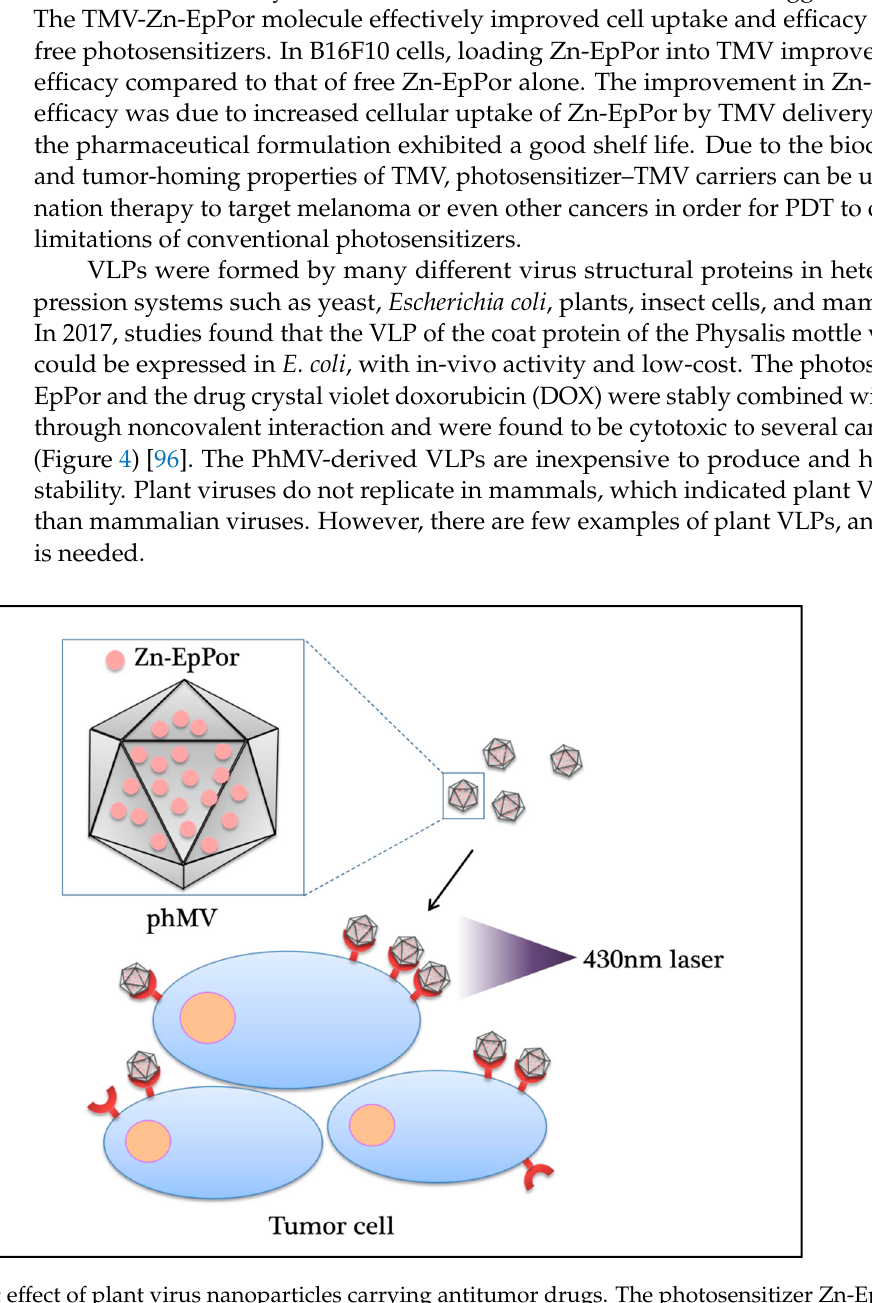
Figure 4. Photodynamic effect of plant virus nanoparticles carrying antitumor drugs. The photosensitizer Zn-EpPor and the drug crystal violet doxorubicin (DOX) stably bind to the VLP of the coat protein of the Physalis mottle virus (PhMV) through noncovalent interactions and are cytotoxic to several cancer cell lines under 430-nm near-infrared laser irradiation. PhMV: Physalis mottle virus; Zn-EpPor: 5-(4-ethynylphenyl)-10,15,20-tris(4-methylpyridin-4-ium-1-yl)porphyrin-zinc(II) triiodide.